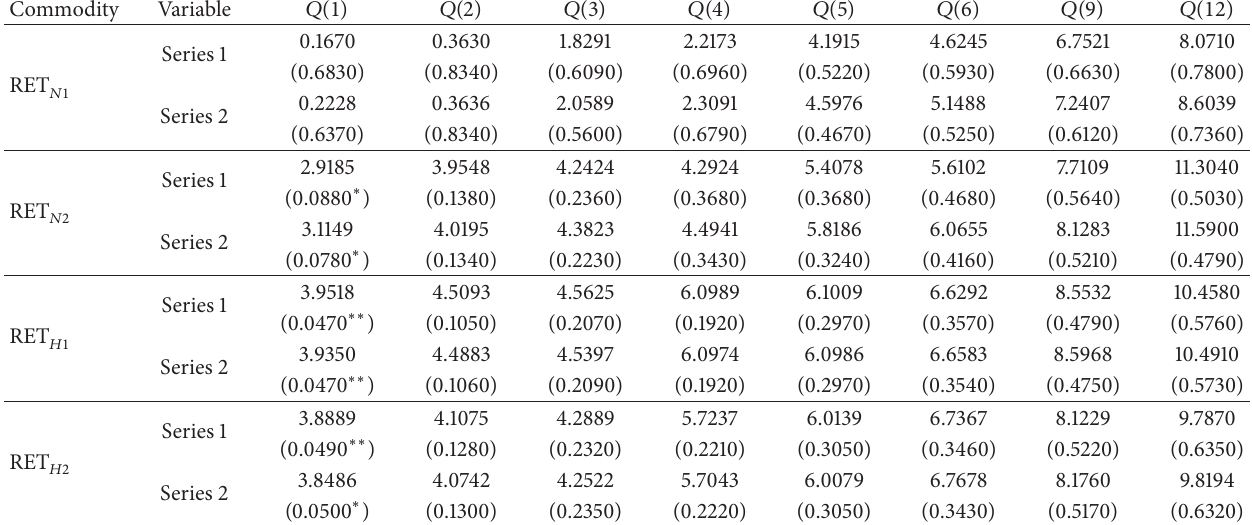
Table 2: Results for Ljung-Box 𝑄 test.